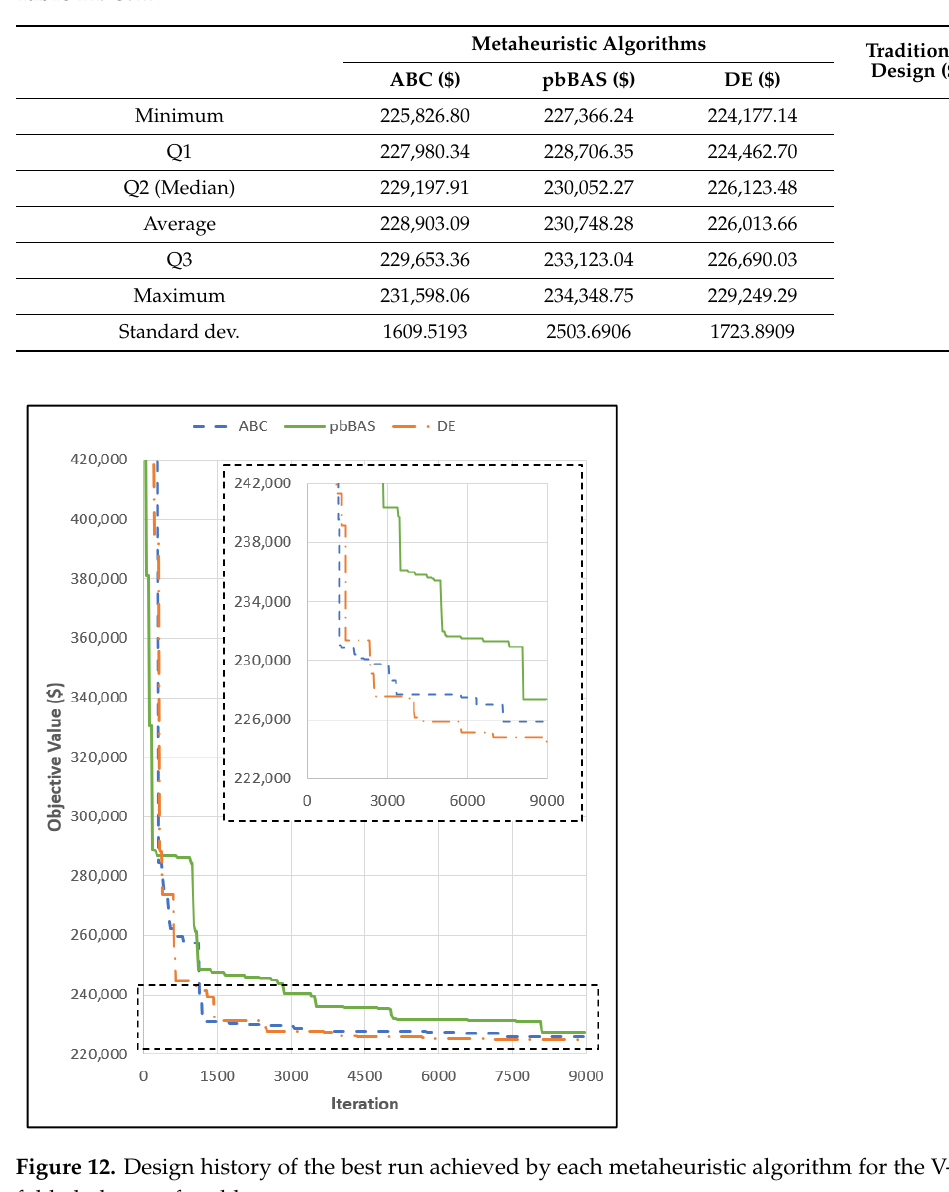
Figure 13. Design history of the sample average of the 10 runs achieved by each metaheuristic algo- rithm for the V-type folded plate roof problem.